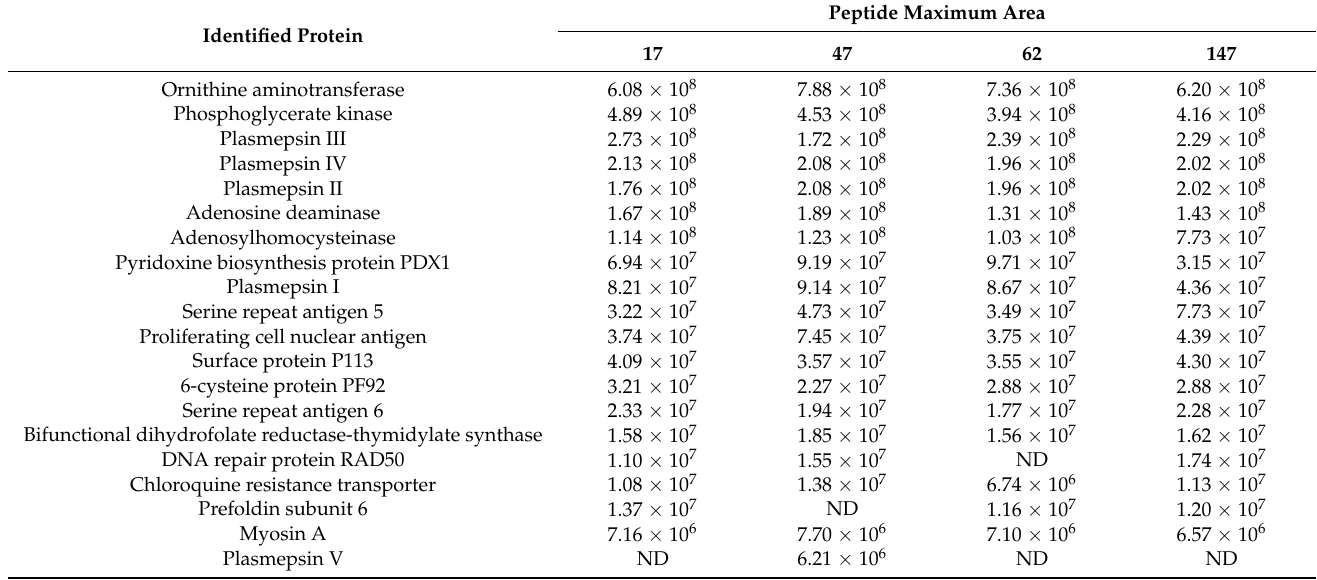
Figure 6. Target validation of candidate compounds by DARTS strategy. ( a ) SDS − PAGE gel of the compound − protein complexes. ( b ) Identification of the plasmepsin V based on the label − free LC − MS/MS analysis. Table 2. The top 20 proteins detected by DARTS and the maximum area of the peptide from the corresponding